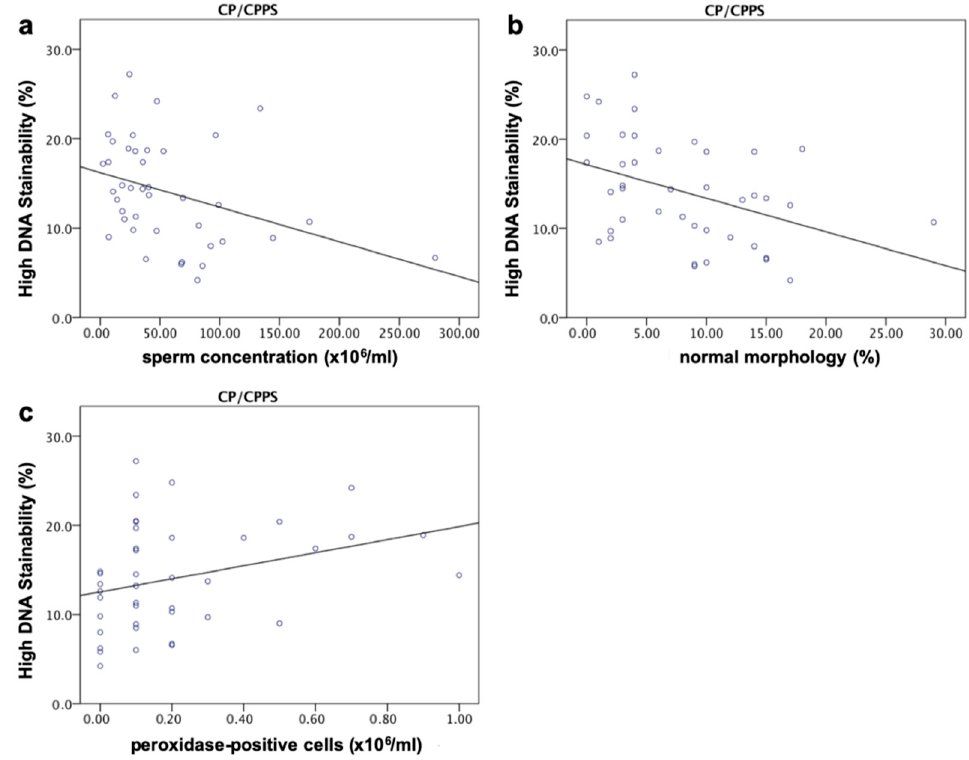
Figure 3. DFI compared after building age-matched groups: ( a ) Age < 34 years DFI: 15.3% (CP/CPPS, n = 11, * marks an outlier) vs. 8.3% (Control, n = 17), p < 0.05. ( b ) Age ≥ 34 years DFI: 23.8% (CP/CPPS, n = 30) vs. 8.5% (Control, n = 5), p = 0.094.